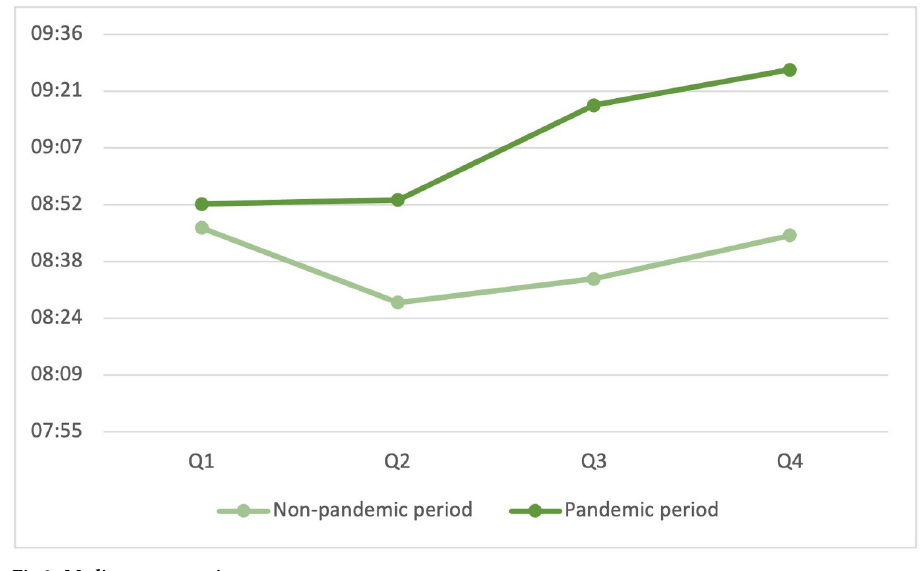
Fig 2. Median response